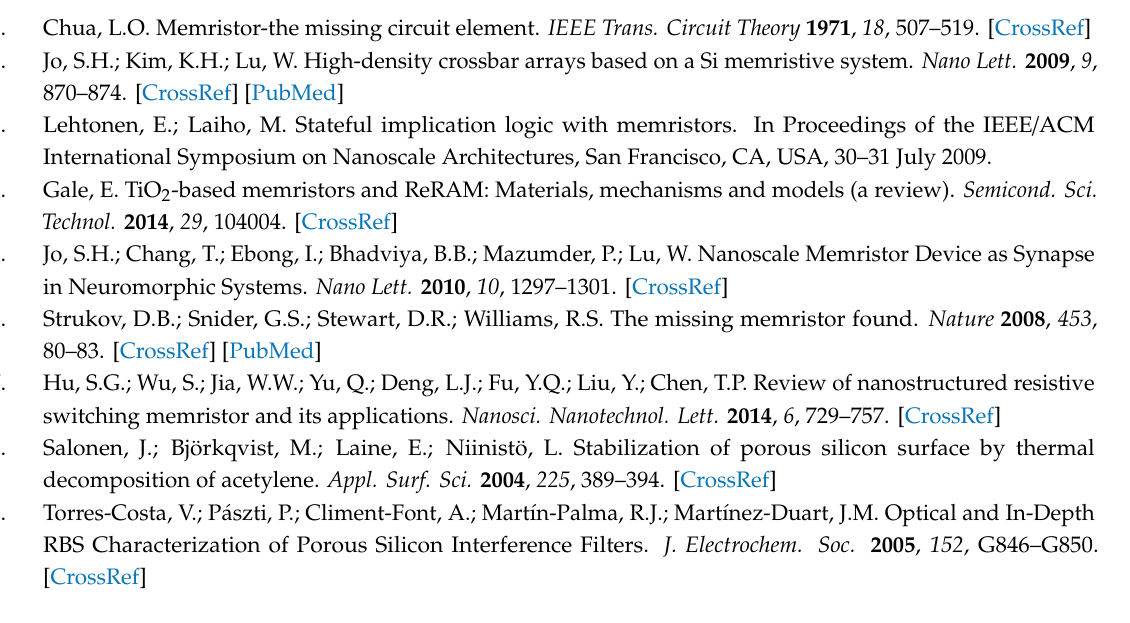
Figure S1.1: XPS spectra of Si 2p and C 1s peaks from a LaCPSi pad and wetOxCPSi. Figure S1.2: XPS spectra of Si 2p (left) and C 1s (right) peaks from a wetOxCPSi. Figure S1.3: Water drops on a hydrophobic HCPSi substrate and on a hydrophilic LaCPSi pad. Optical microscopy image of an intact LaCPSi pad after the as-anodized porous silicon has been dissolved away with 1 M NaOH. Figure S2: Procedure of the stimulation experiments on LaCPSi. Table S1: XPS results of a laser carbonized pad and the thermally hydrocarbonized PSi